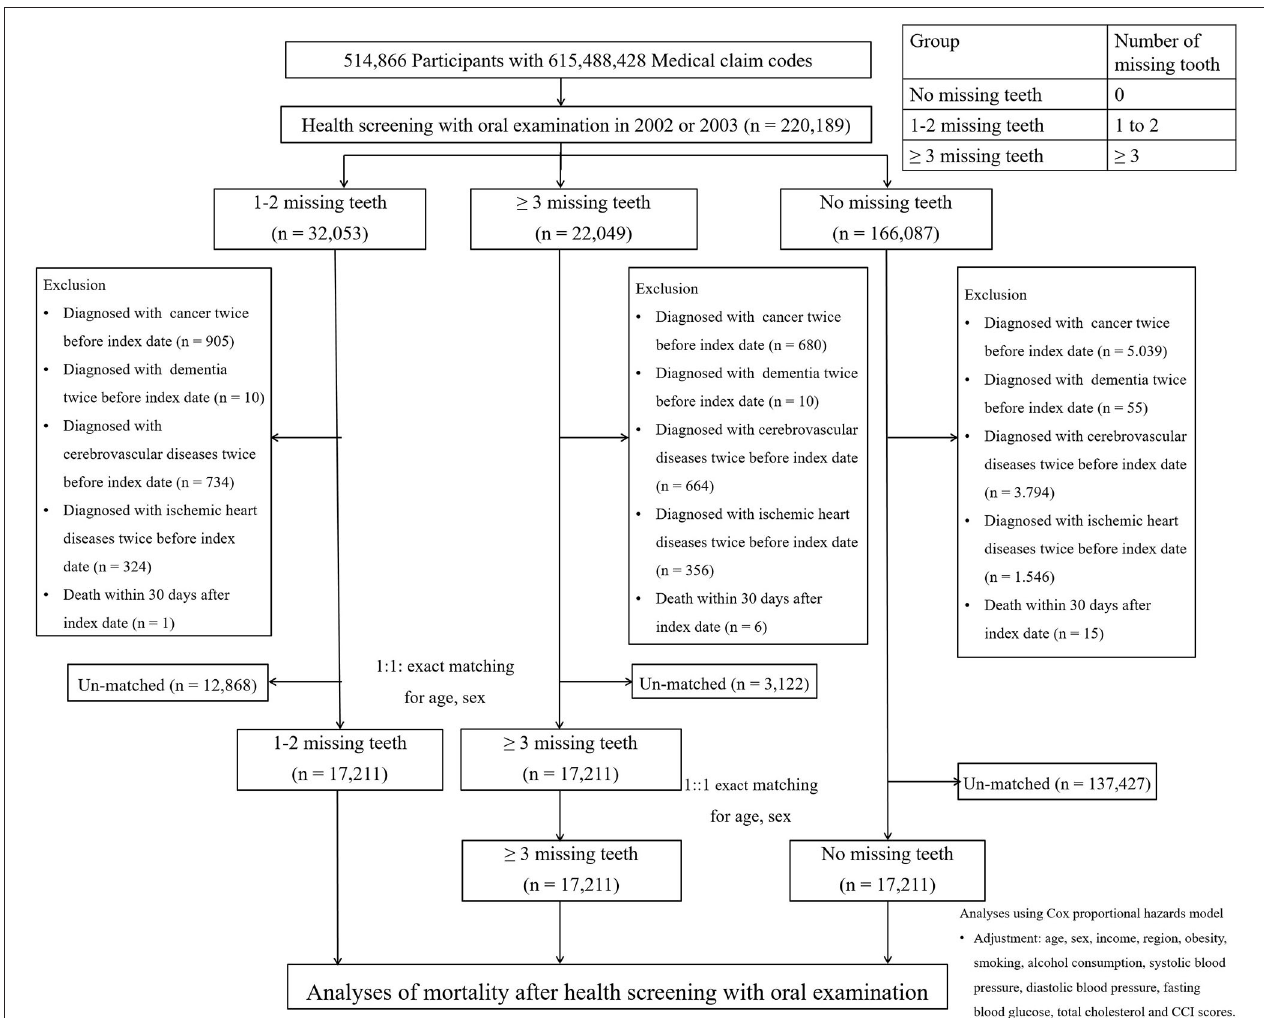
FIGURE 2 | Design of the current study. A total of 17,211 participants included in the groups of ≥ 3 missing teeth, 1–2 missing teeth, and no missing teeth were matched 1:1:1 for age and